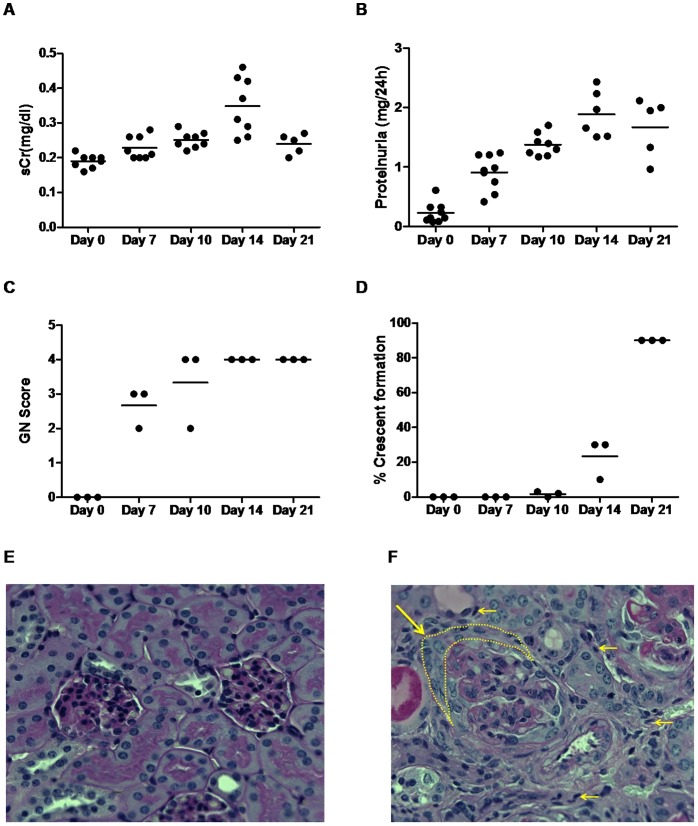
Renal dysfunction and pathological changes during anti-GBM antibody–induced nephritis.Following the challenge with anti-GBM serum, 129×1/SvJ mice (n = 3–9 per group) showed increased serum creatinine (sCr) levels (A) and proteinuria (B); Kidney specimens from all anti-GBM nephritis mice were examined by light microscopy for evidence of glomerular nephritis (GN score) (C), and glomerular crescent formation (D). Representative Periodic Acid Schiff (PAS) staining on day 0 (E) and day 14 (F) (yellow dash line indicates the formation of crescent). F also shows severe inflammatory cell infiltration in the tubular-interstitial area of anti-GBM nephritic mice as indicated by yellow arrows. The severity of GN score was graded on a 0–4 scale as follows: 0, normal; 1, mild increase in mesangial cellularity and matrix; 2, moderate increase in mesangial cellularity and matrix, with thickening of the GBM; 3, focal endocapillary hypercellularity with obliteration of capillary lumina and a substantial increase in the thickness and irregularity of the GBM; and 4, diffuse endocapillary hypercellularity, segmental necrosis, crescents, and hyalinized end-stage glomeruli.